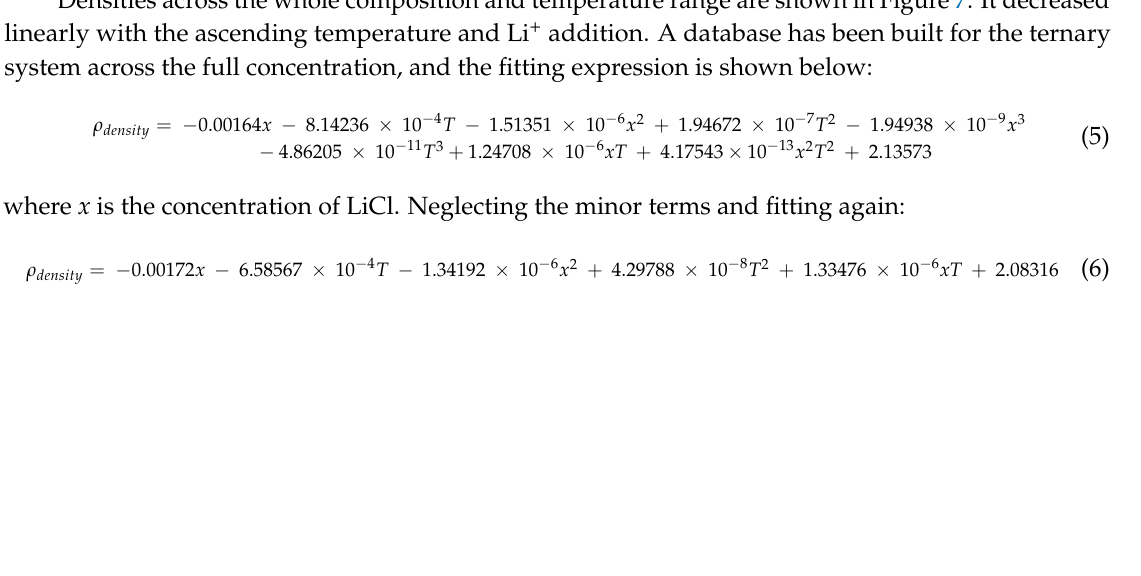
Figure 7. Surface map of simulated density results. As listed in Table 4, the absolute values of the slopes of fitted lines become smaller with the addition of lithium ions, which indicated that the slope decreased slower with ascending temperature as the LiCl addition increased. Derived from Wang et al.’s [15] work, pure LiCl has the smallest slope in LiCl, NaCl, and KCl. Therefore, the higher LiCl concentration was, the more slowly the density changed along the temperature.